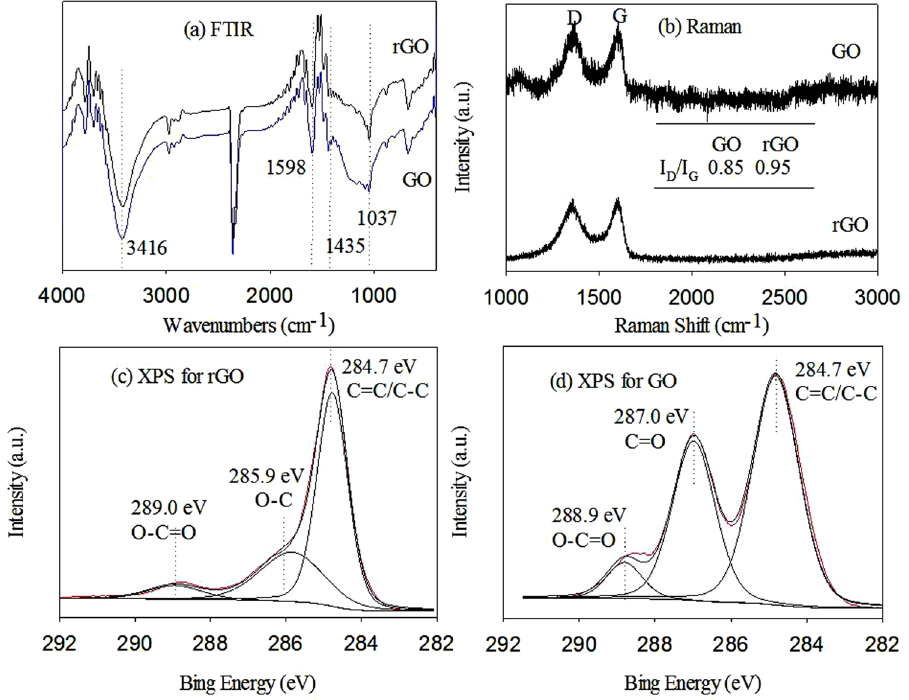
Figure 1. Surface and structural characterization of graphene oxide (GO) and reduced GO (rGO). FTIR spectra of GO and rGO ( a ), Raman spectra of GO and rGO ( b ), XPS spectra of rGO ( c ) and GO ( d ) for C 1